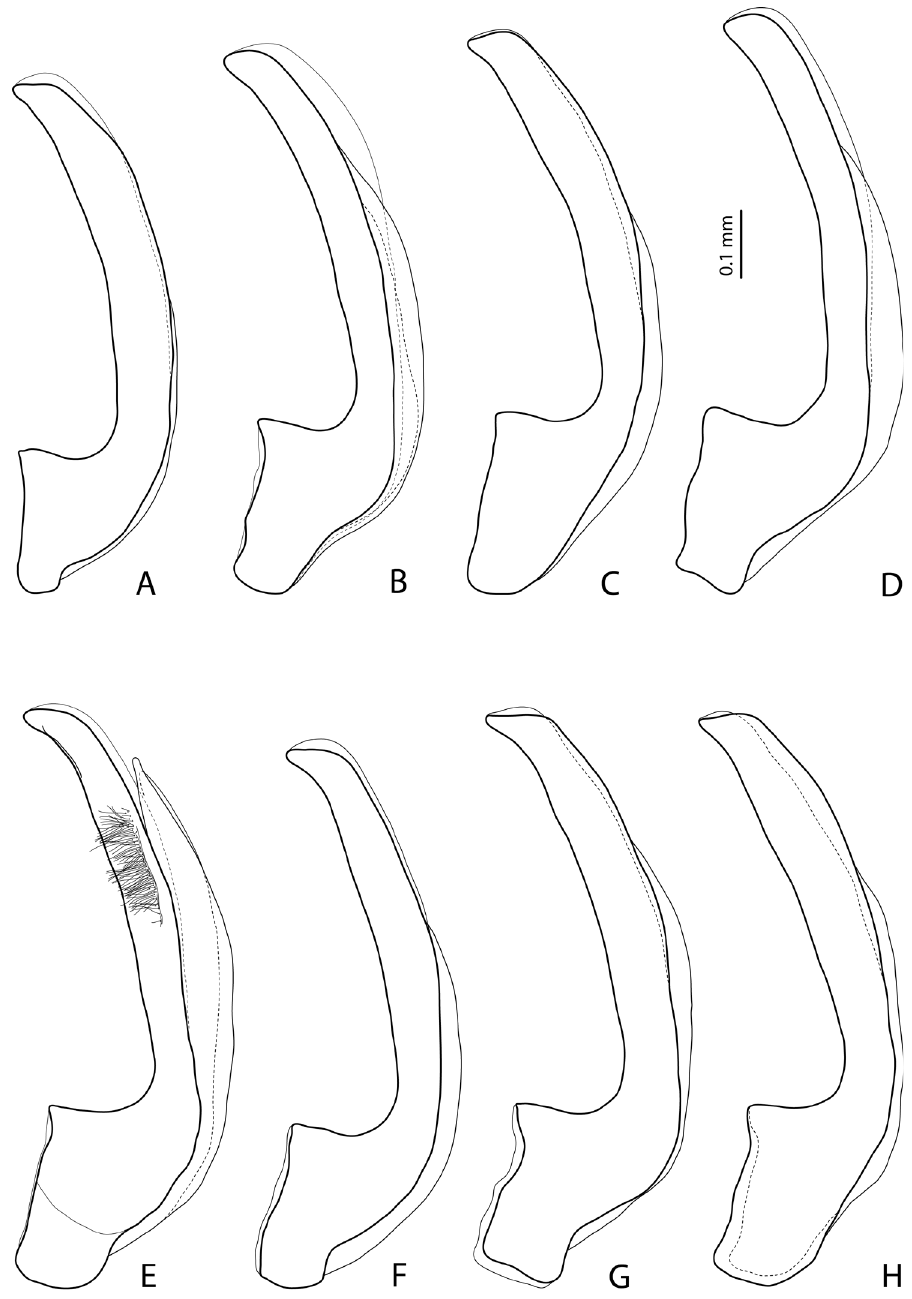
Figure 16. Exocelina damantiensis (Balke, 1998), PNG, median lobe in lateral view, setae are not shown A Madang, Brahman-Bundi, paratype of E. madangensis (Balke, 2001) B Madang, Akameku-Brahman, PNG114 C Madang, Damanti, paratype of E. damantiensis D Morobe, Yakob, PNG74 E Morobe, Lae- Bulolo, paratype of E. patepensis (Balke, 1998) F Morobe, Kwapsanek, PNG25 G , H Morobe,